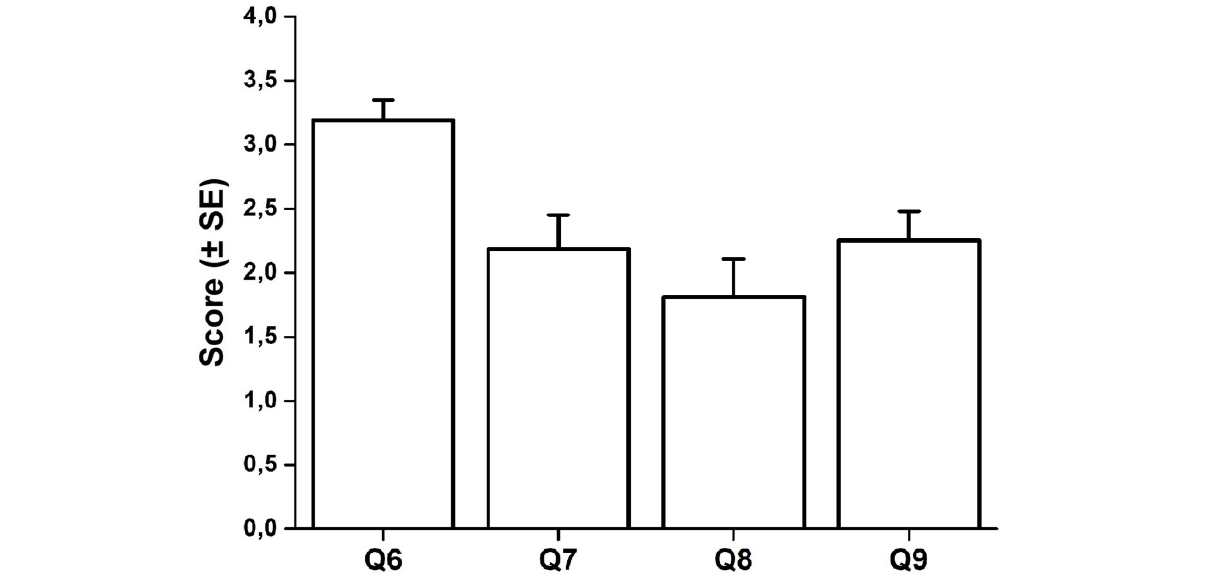
Figure 5. Results from the questionnaire on the motivation and compliance to use COGNI-TRAcK. The columns indicate the mean value obtained for compliance on a scale from 0 to